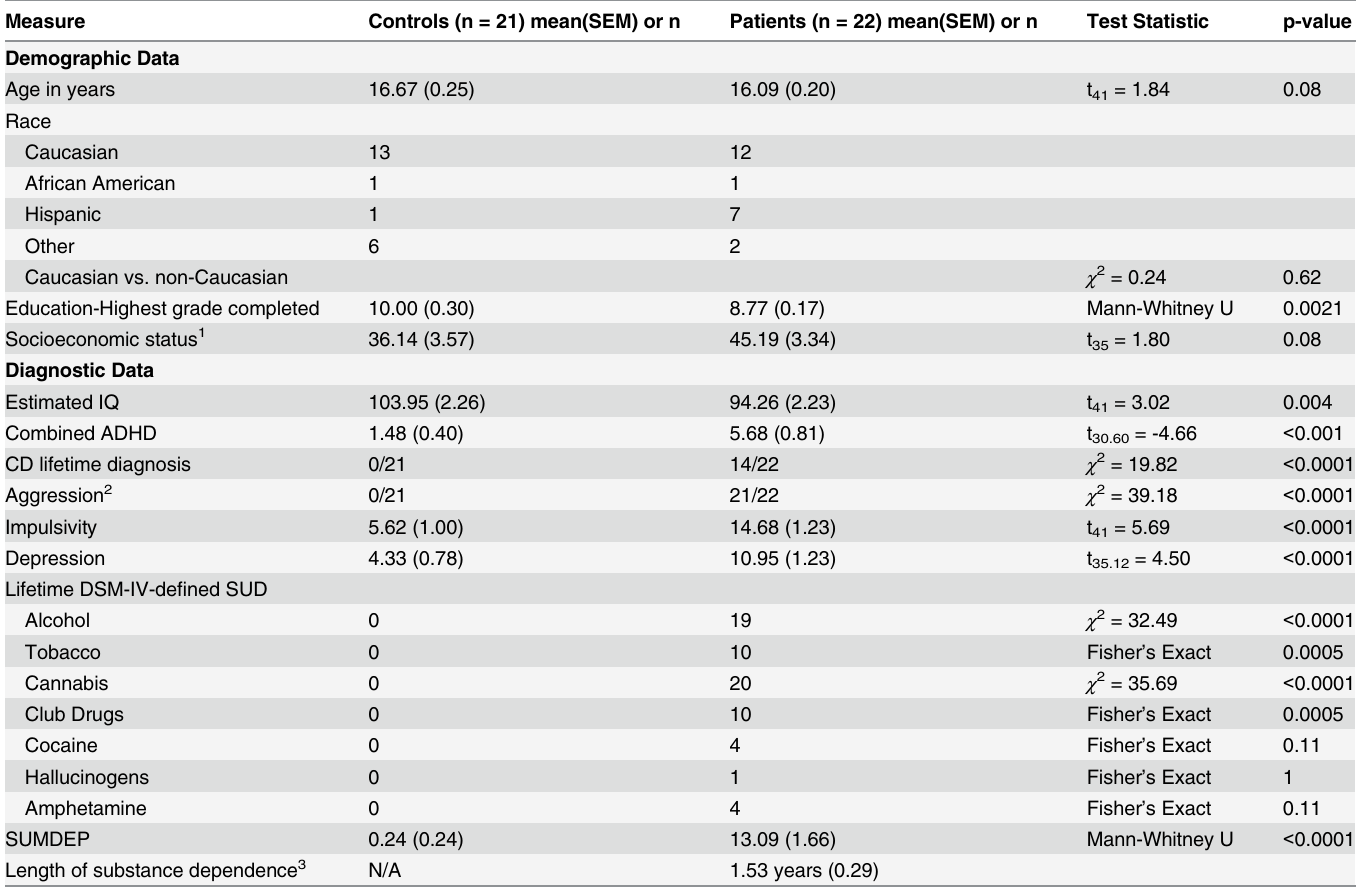
Table 1. Adolescent controls and patients: comparing demographic and diagnostic